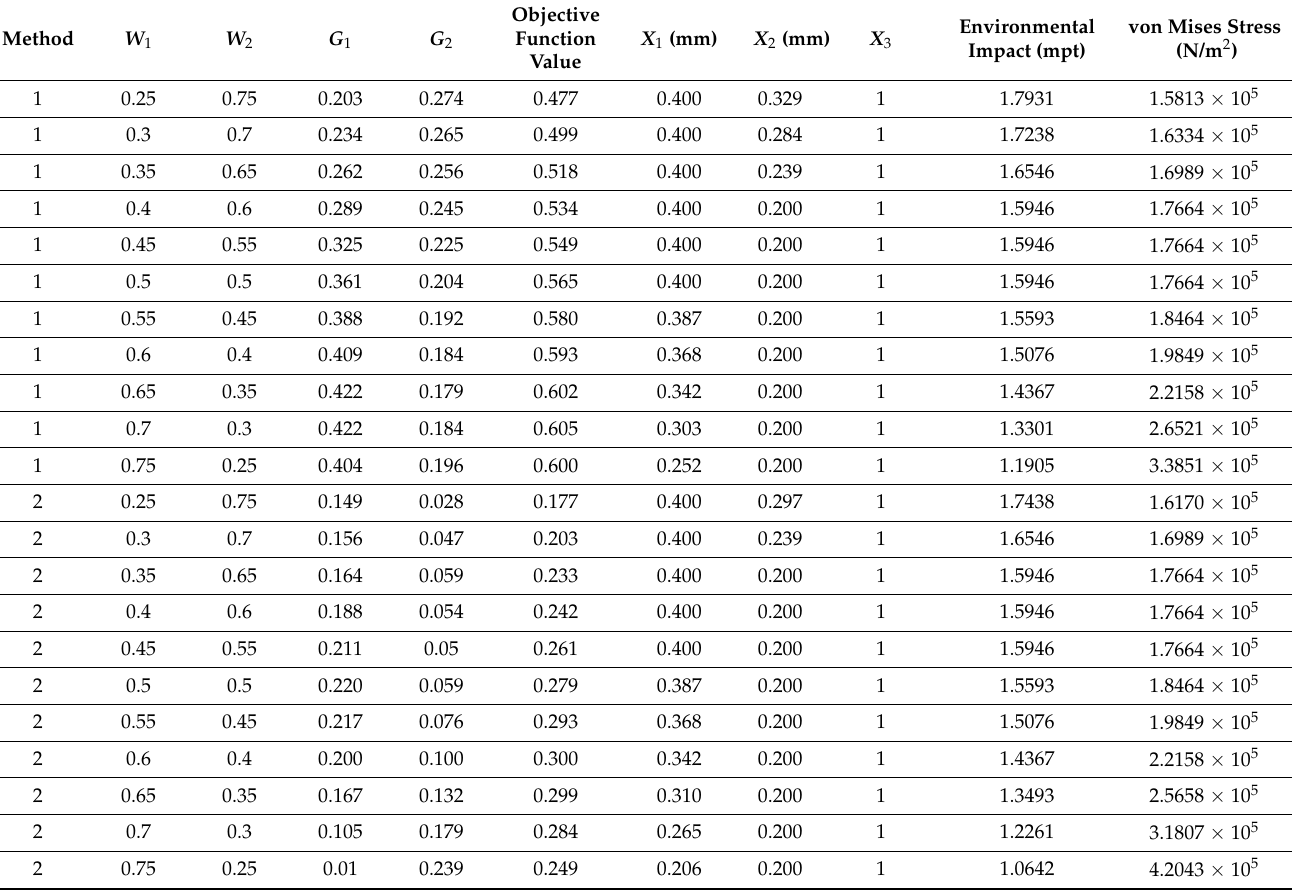
Table 4. Multi-disciplinary and multi-objective optimization results based on Method 1 and Method